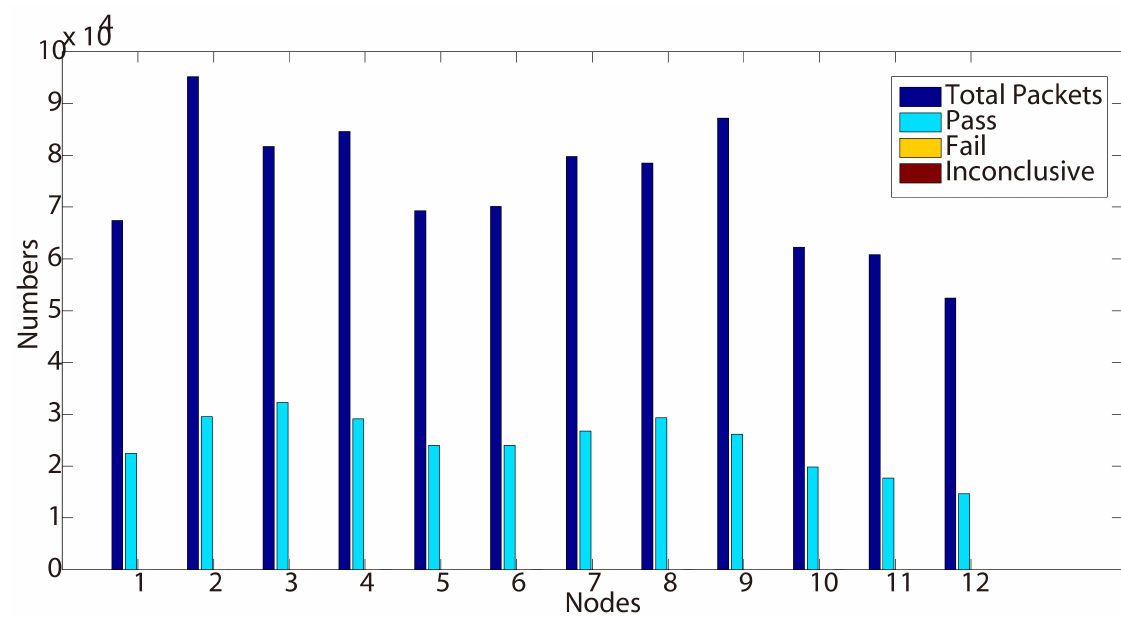
Figure 6. Test results for Property 4 (Day 1).